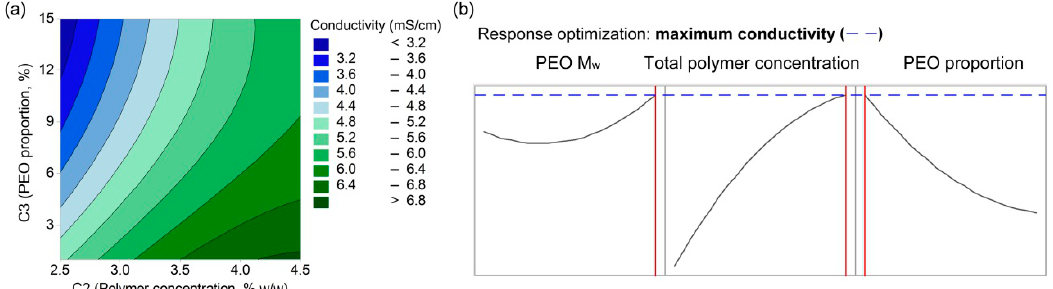
Figure 6. ( a ) contour plot of the polymer-blend solution conductivity as a function of PEO proportion and total polymer concentration; ( b ) response optimization plots of the polymer-blend solution conductivity as a function of PEO M w , total polymer concentration, and PEO proportion.